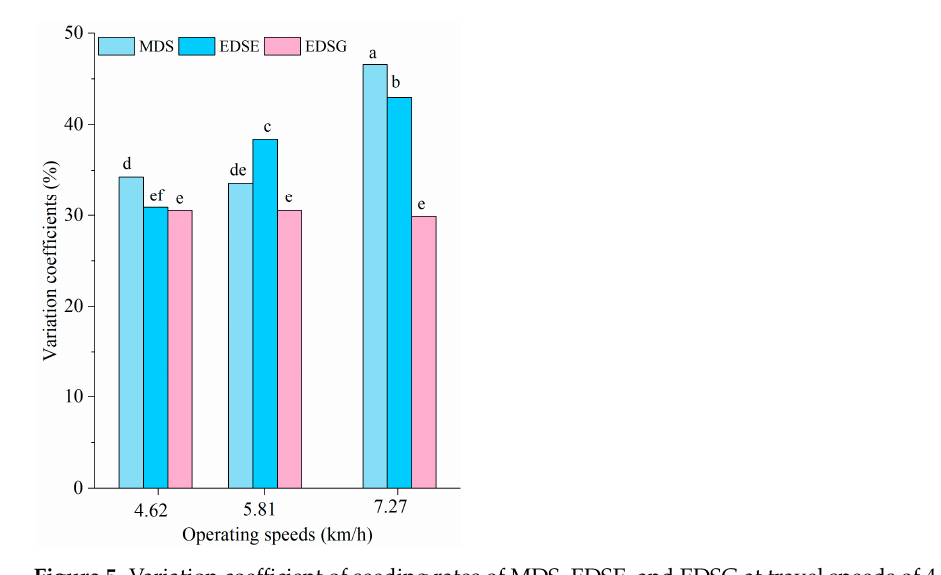
Figure 5. Variation coefficient of seeding rates of MDS, EDSE, and EDSG at travel speeds of 4.62, 5.81, and 7.27 km·h − 1 . Different lowercase letters mean significant difference at the 0.05 level.